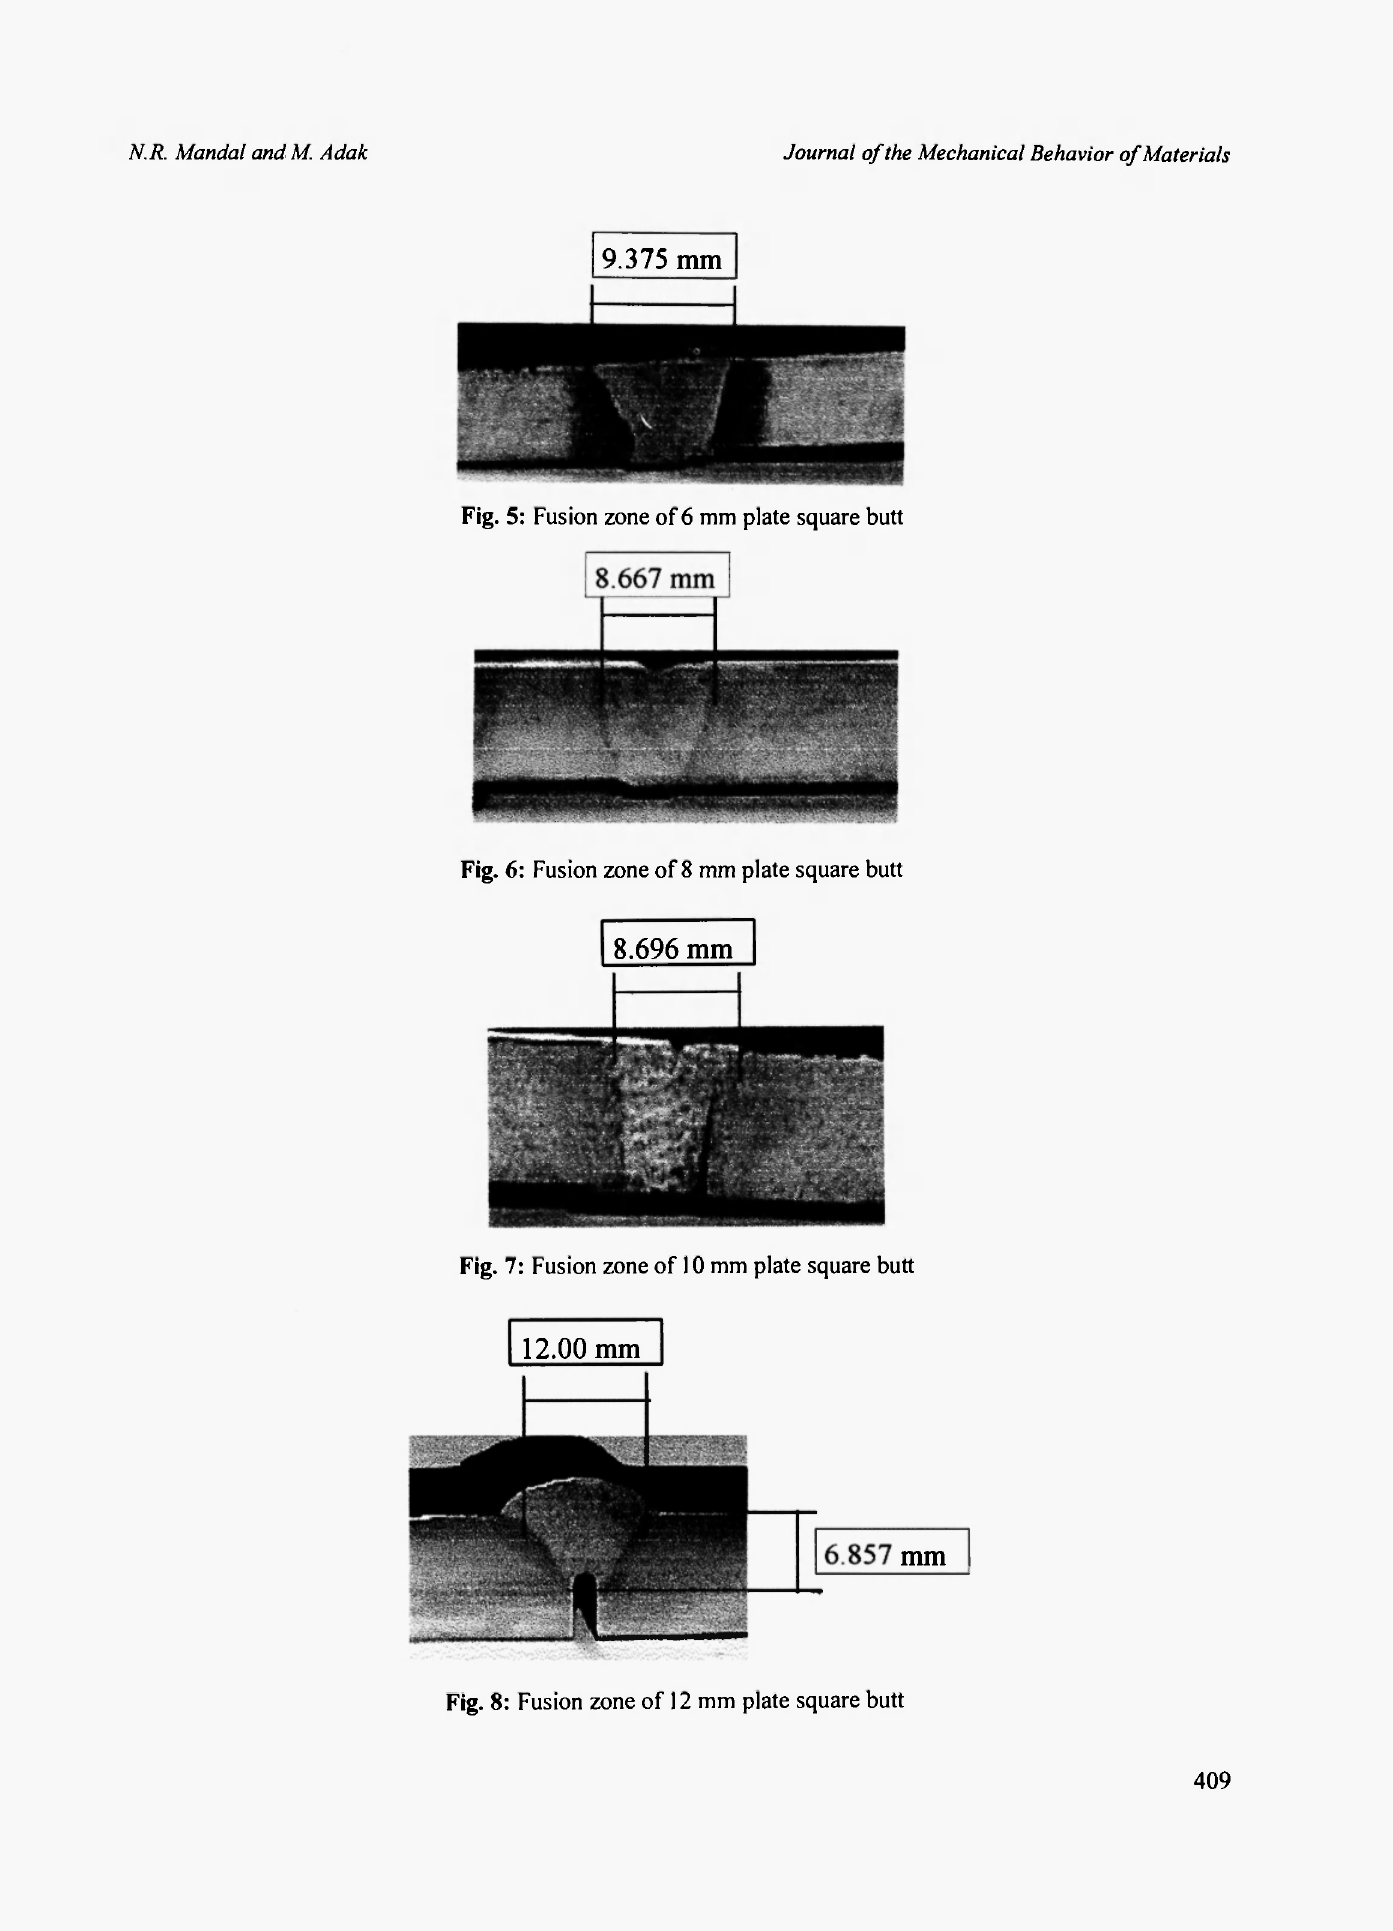
Fig. 8: Fusion zone of 12 mm plate square